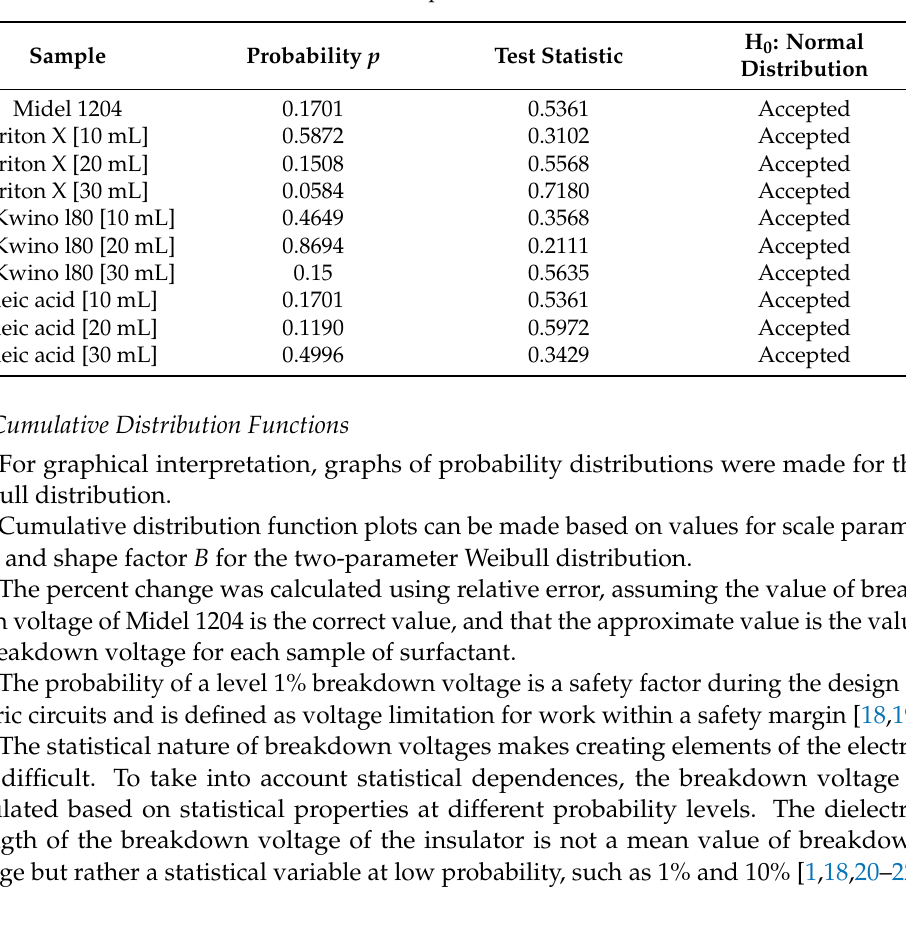
Table 5. Tests of Weibull distributions for all